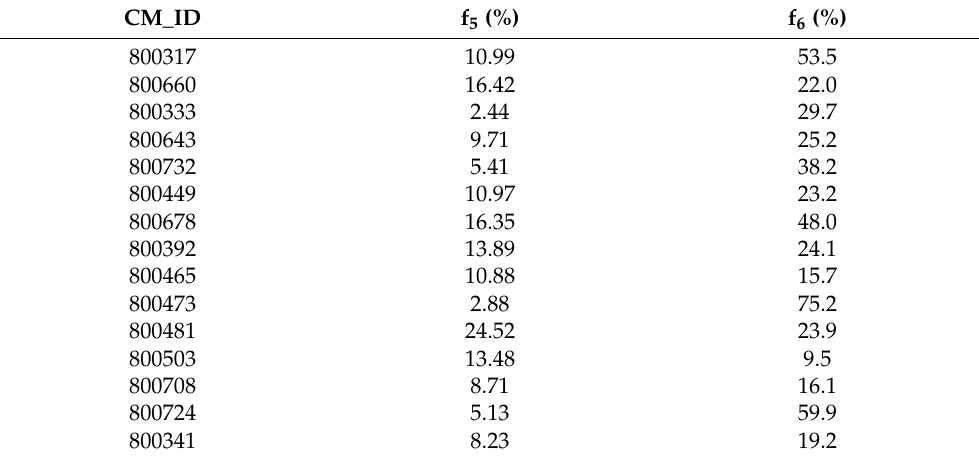
Table 2. Data taken from the database of the Secretariat for Agriculture of the Municipality of Bela